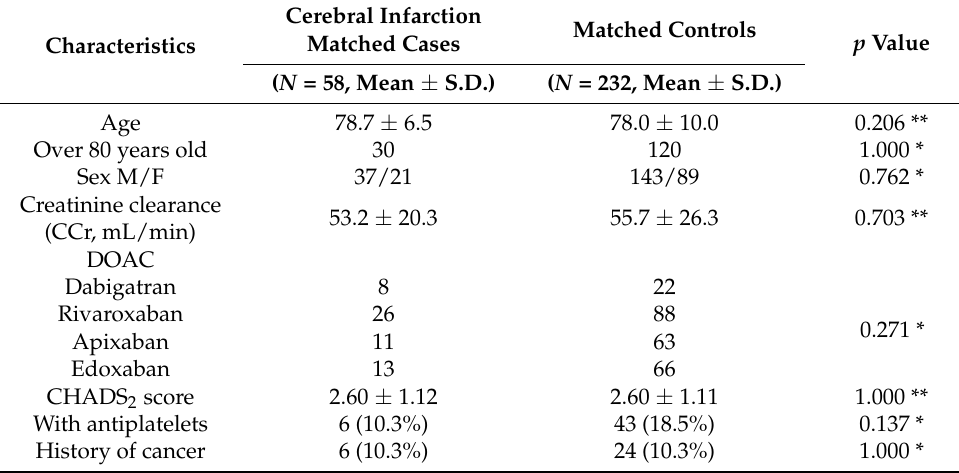
Table 3. Clinical characteristics of the study patients (after matching).